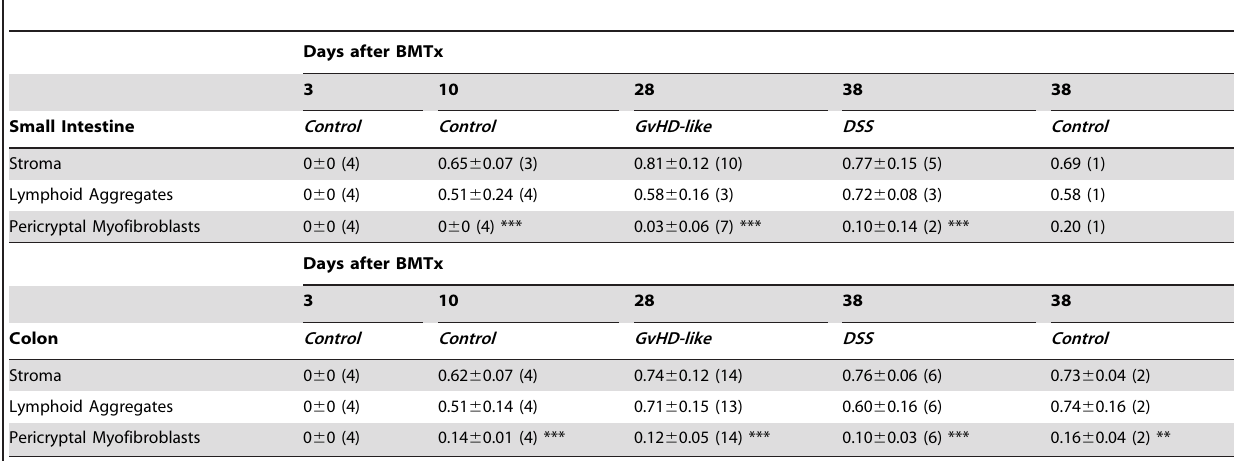
Table 1. Proportions of Y chromosome-positive cells in intestinal populations of female Rag2 KO mice receiving male SWR Bone Marrow.